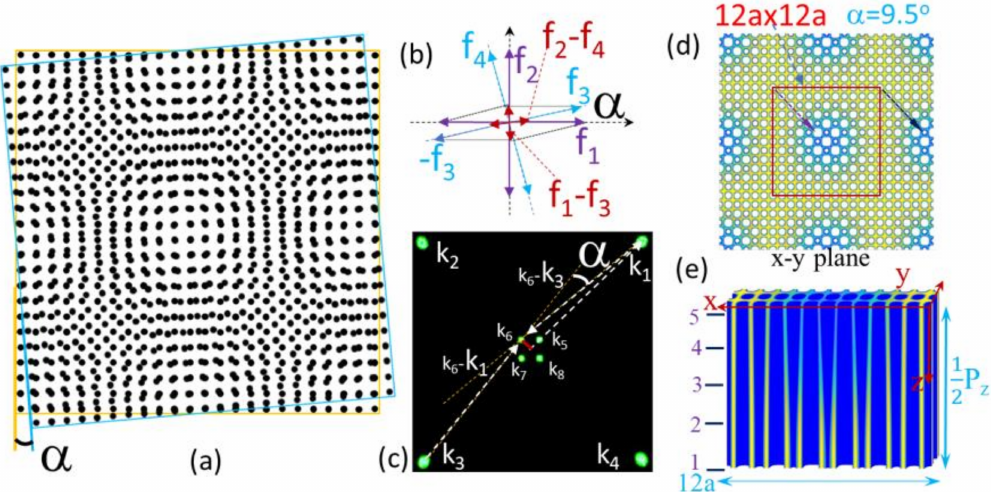
Figure 1. ( a ) A ((1, 0, − 1, 0), (0, 1, 0, − 1)) moir é in the superposition of two square dot patterns with a twist angle of α ( b ) and its first-order spectra; ( c ) components of k -wave-vectors in the x–y plane for eight interfering beams before their overlapping; ( d ) inverted 2D moir é interfere pattern with a twist angle of 9.5 degrees and super-cell size of 12a × 12a; and ( e ) inverted 3D interfere pattern. The labels of 1, 2, 3, 4, and 5 indicate the z -locations from the